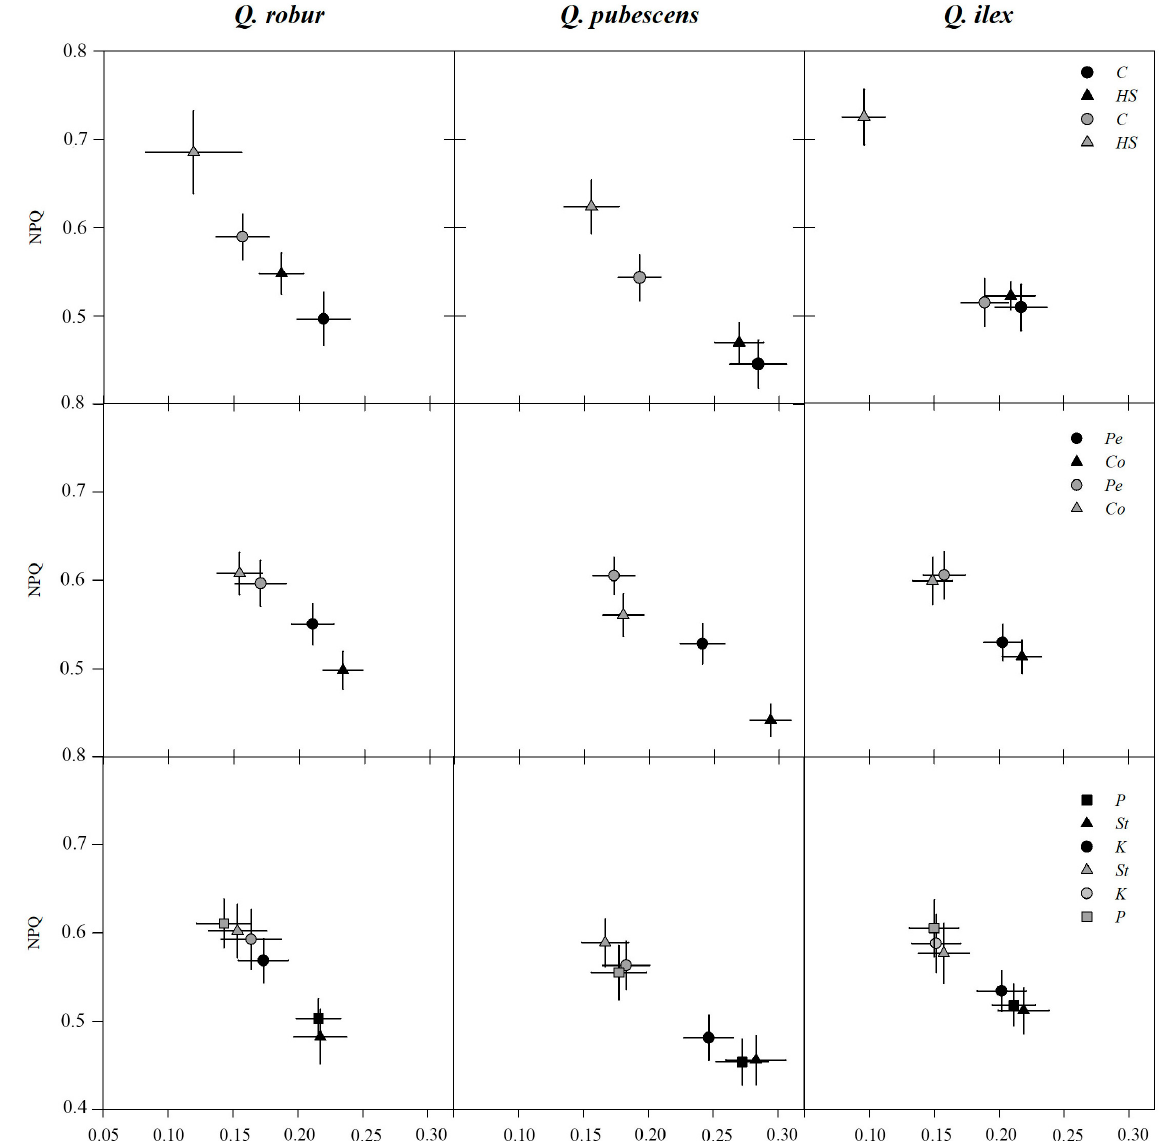
Figure 3. Fluorescence quantum yields ( Φ II and Φ NPQ ; mean and CI 95% bars) at T 0 (black symbols) and T 1 (grey symbols) for water stress ( top ), substrate ( mid ), and fertilization ( bottom ). When CI 95% bars overlap data are not significantly different. Levels: C, HS : control, high water stress; Pe , Co : peat and coir substrate St, P, K : standard, P- enriched, K-enriched fertilization.